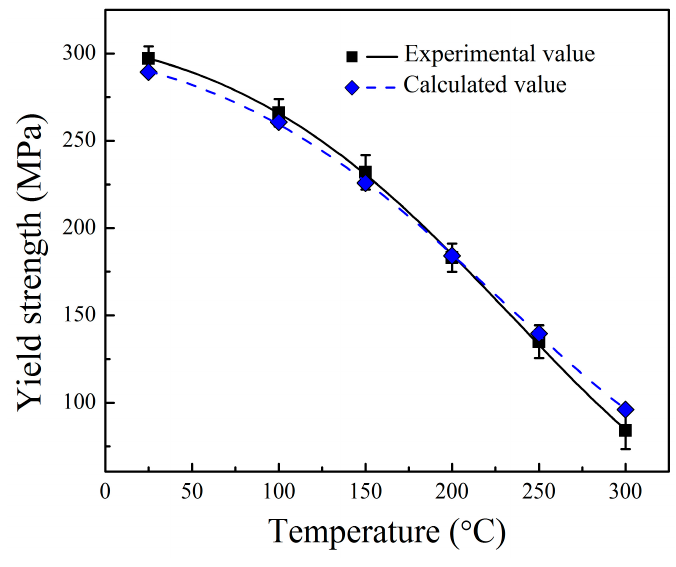
Figure 6. Comparison between theoretical calculation and experimental results.